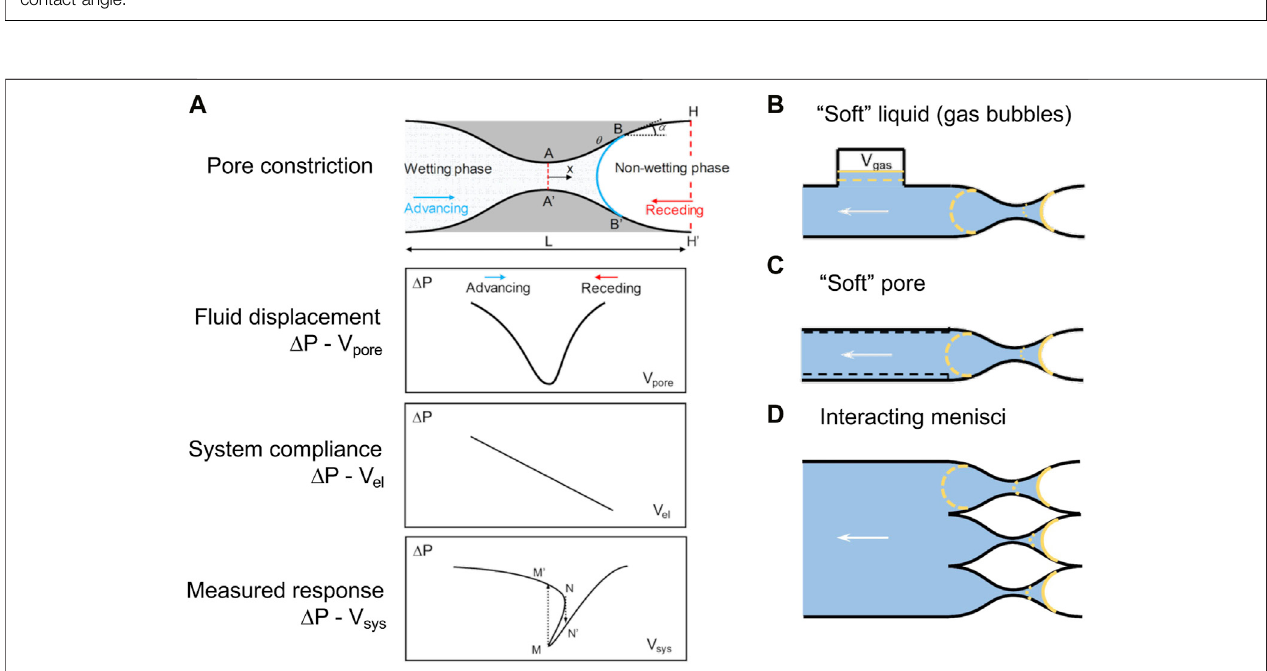
FIGURE 4 | Haines jumps. (A) Elastic and capillary interactions. Pore scale mechanisms: (B) soft fl uid by entrapped gas bubble; (C) deformable soft matrix; (D) interacting menisci (modi fi ed from Sun and Santamarina, 2019b).